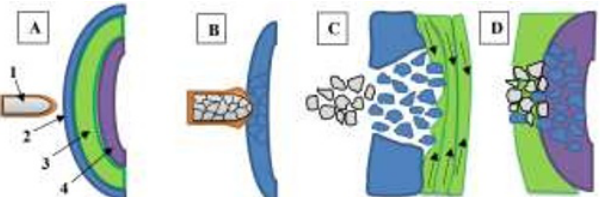
Fig. 1. Description of a cross-section of a hard core projectile / multi components soldier armour (a) and the various events from projectile impact to full arrest (b)-(d) [3]